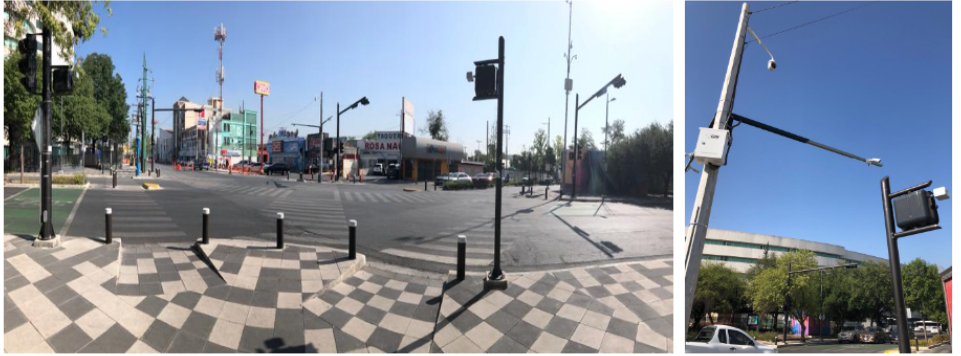
Figure 7. Complete streets and traffic monitoring system located within